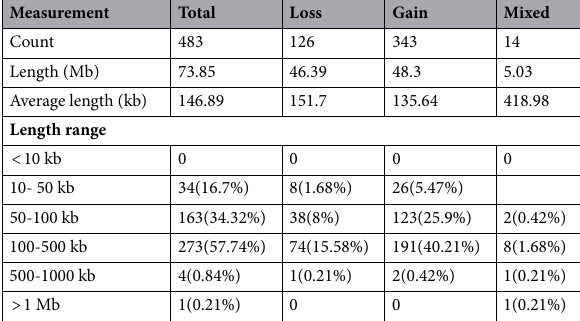
Table 3. CNVRs Information in two tail type Iranian sheep